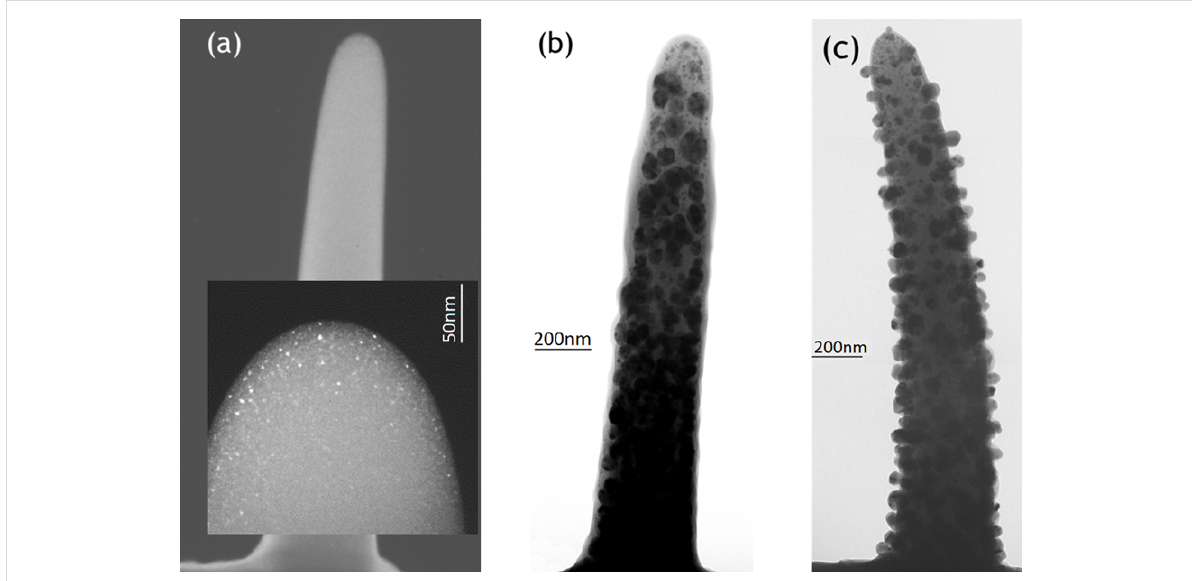
Figure 7: TEM in situ annealing of FEBID rods grown from (hfac)Cu(VTMS). a) Dark field image of an as-deposited freestanding rod. Inset: rod apex with small Cu nanocrystals in carbonaceous matrix. b) Bright-field image of same rod after 270 °C annealing and continuous TEM observation (200 keV). Large Cu nanocrystals form inside the rod. c) Bright field image of another rod not observed during the same annealing process. Cu nanocrystals form at the outside surface of the rod.